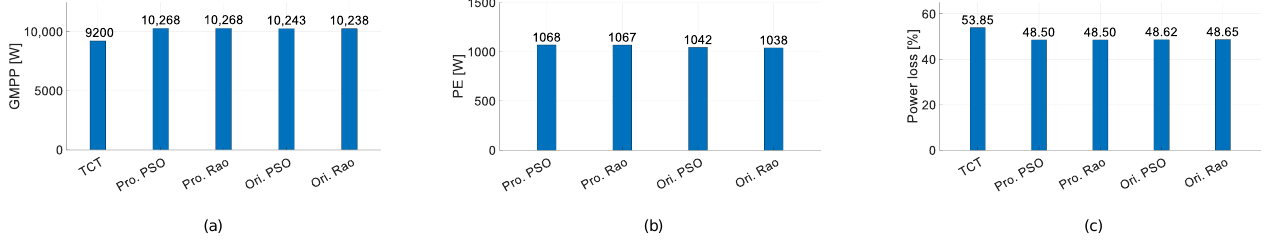
Figure 13. Comparison of performance metrics of PV array under the center of the cloud. ( a ) GMPP. ( b ) PE. ( c )